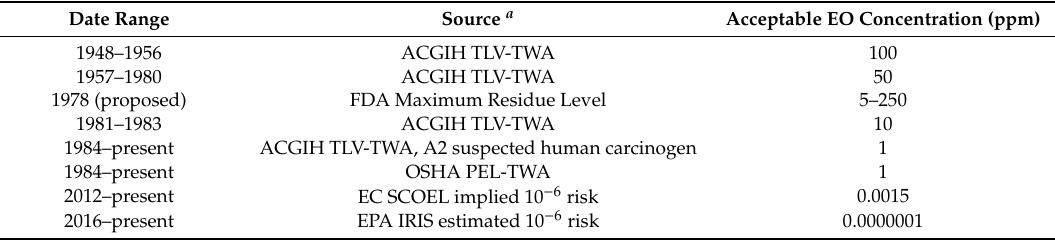
Table 1. Historical summary guidance values and standards for EO